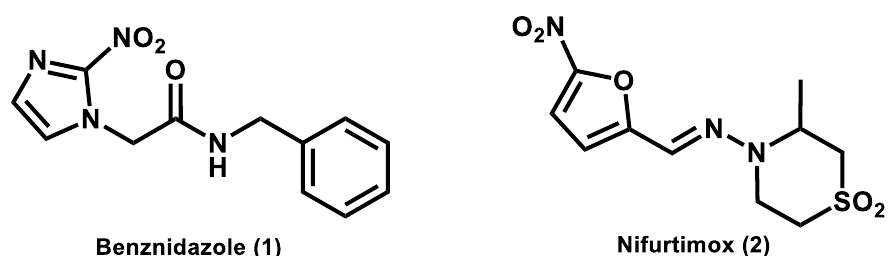
Figure 1. Structures of benznidazole and nifurtimox, which are the only two available drugs for the chemotherapy of Chagas’ disease.